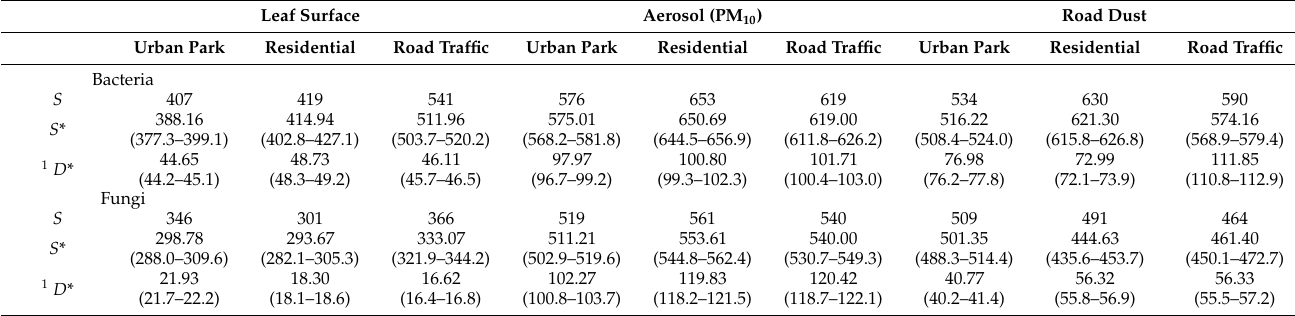
Table 1. Alpha-diversity parameters for all bacterial and fungal species-level OTUs found in the investigated type of samples (Leaf, Surface, aerosol PM 10 and Road Dust) in three urban sites of Rome (Urban Park, Residential and Road Traffic): Hill numbers of order q [36], species richness ( S ), species richness ( S *), and exponential of Shannon entropy ( 1 D *) calculated on data rarefied to the smallest library size were